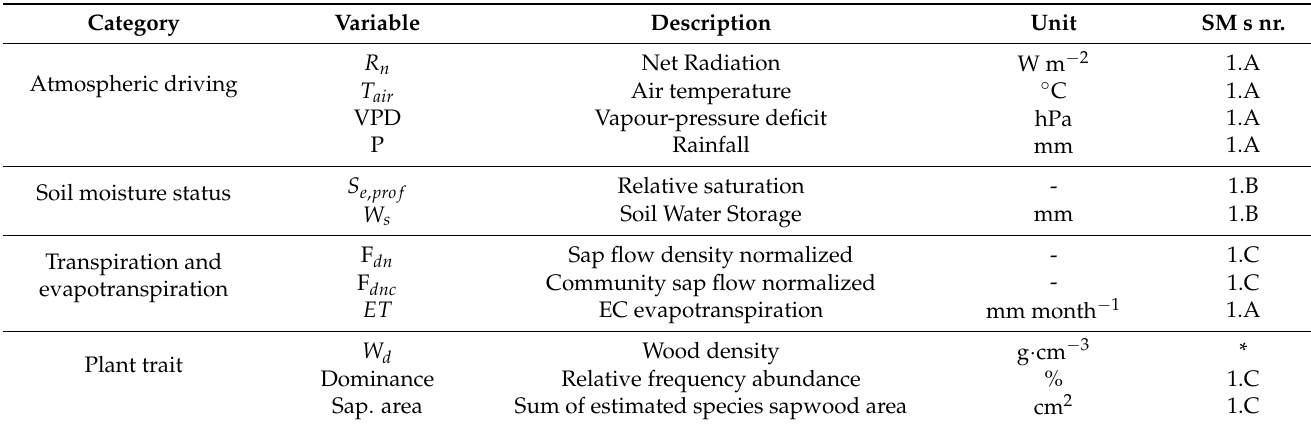
Table 2. Summary of measured or derived environmental variables: category of the variable; name; description; units; section number. See the Supplementary Material for more